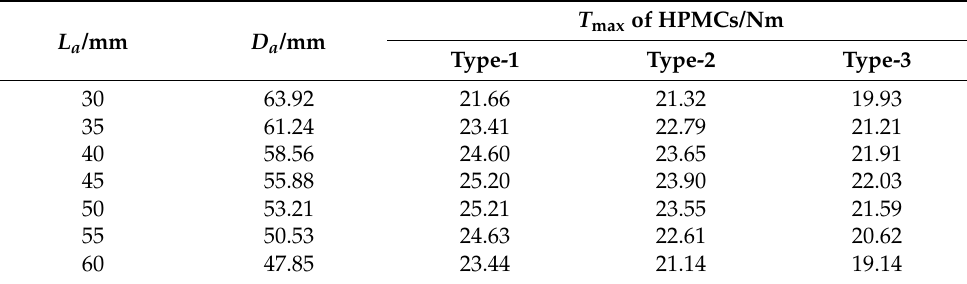
Table 2. T max of three types of cylindrical HPMCs with different sizes.